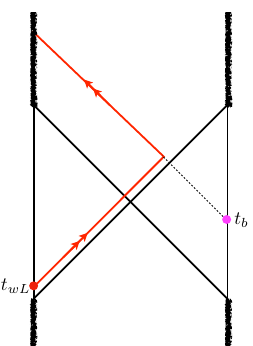
Figure 1 . A charged shell sent in from the left at time t wL can bounce in the interior close to the event horizon. An observer on the right can meet the shell only if they fall in before time t b